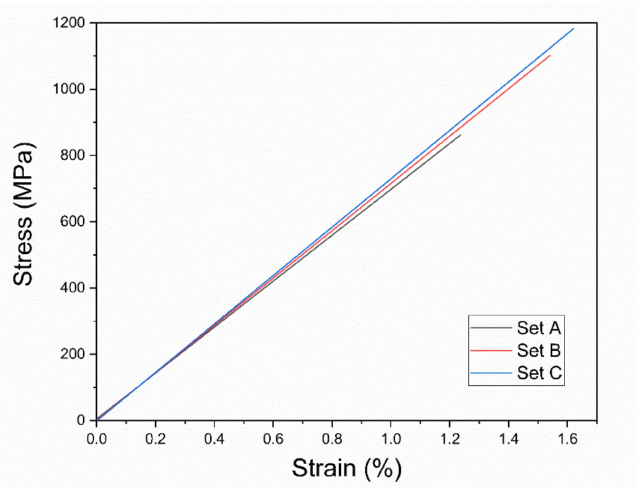
Figure 5. Stress-strain curve of tensile tests for Sets